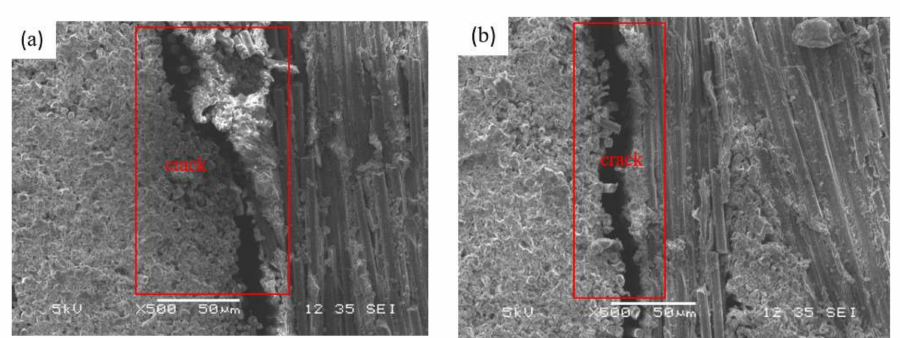
Figure 10. SEM image of crack propagation (500 × ). ( a ) 26.6% CF, ( b ) 76.4%